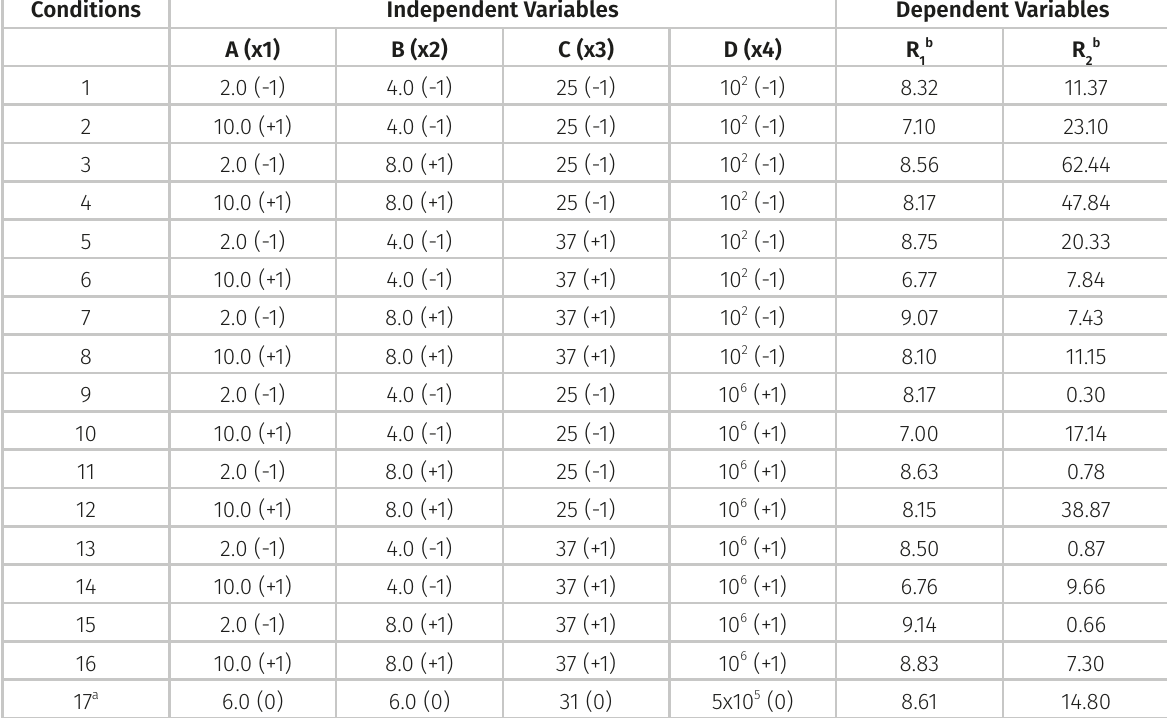
Table II. Complete factorial design to analysis the main effects and interactions among independent